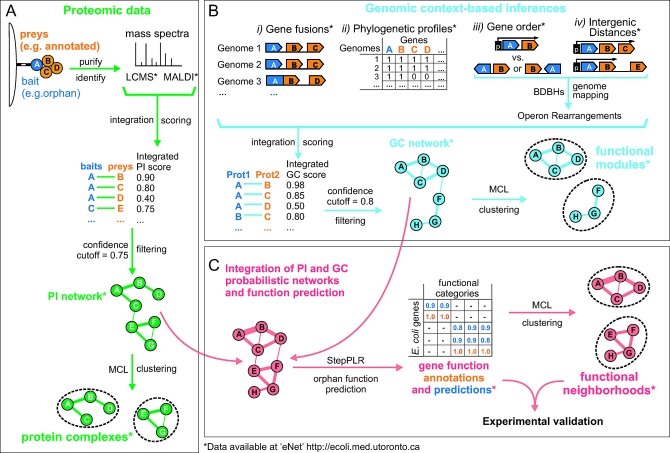
Generation and Integration of Physical and Functional Networks and Orphan Function Prediction(A) Construction of a PI network based on protein copurification and detection by mass spectrometry. The confidence scoring of the LCMS and MALDI networks was conducted using a logistic regression with datasets consisting of PI from low-throughput studies curated in DIP, BIND, and IntAct (gold positives) and proteins in different subcellular localizations (gold negatives). The two networks were integrated using a probabilistic model [61] (Protocol S6). The resulting PI network, with edge weights corresponding to likelihood ratios, was clustered using MCL to delimit “multiprotein complexes.”(B) Integration of four GC methods into a single functional interaction network using the same probabilistic model [61] and resulting scores (edge weights) were input to MCL to delimit “functional modules.”(C) Orphan function prediction was conducted using a “guilt-by-association” procedure. After integration of PI and GC interactions into a single probabilistic network [61], a machine learning algorithm (StepPLR) newly developed for this study was used to assign functions based on the binary associations of orphans with annotated proteins, the respective interaction edge weights, and the overall network topology. Correlations between vectors of these function predictions (orphans), and the annotations were then used as input to delimit “functional neighborhoods” by clustering using MCL.